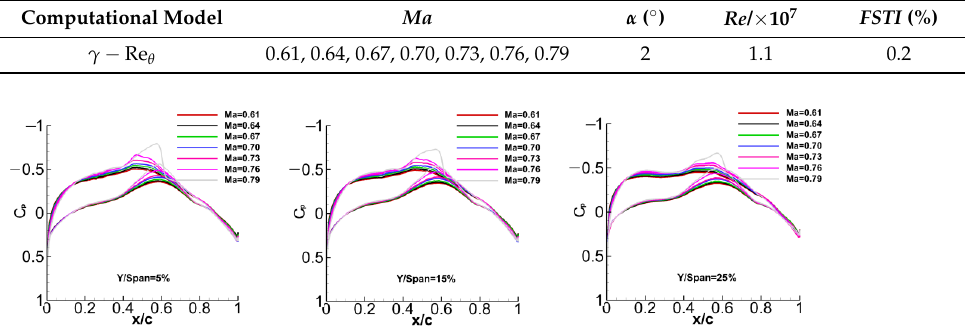
Figure 16. Comparison of C p curves of the central experiment wing with different Ma at various